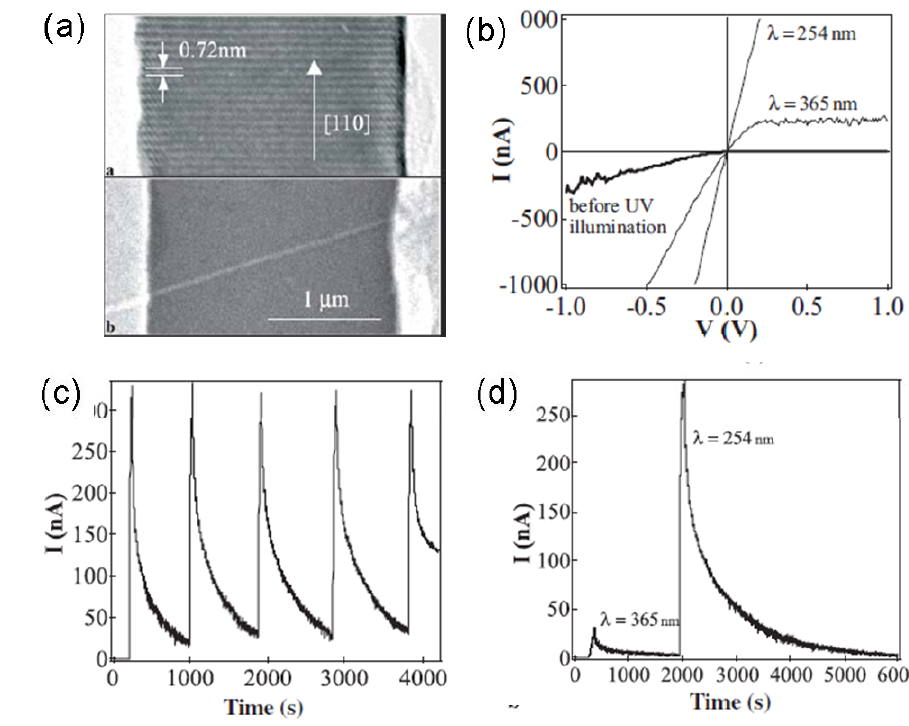
Figure 8. (a) HRTEM image of an In curves recorded before UV light illumination and after exposure to UV light at a wavelength of 365 nm and 254 nm, respectively; (c) I-t curves recorded with the 254 nm UV light illumination turned on and off repeatedly; (d) Photoresponse of the In sequential UV illumination at a wavelength of 365 nm and 254 nm. Reproduced from